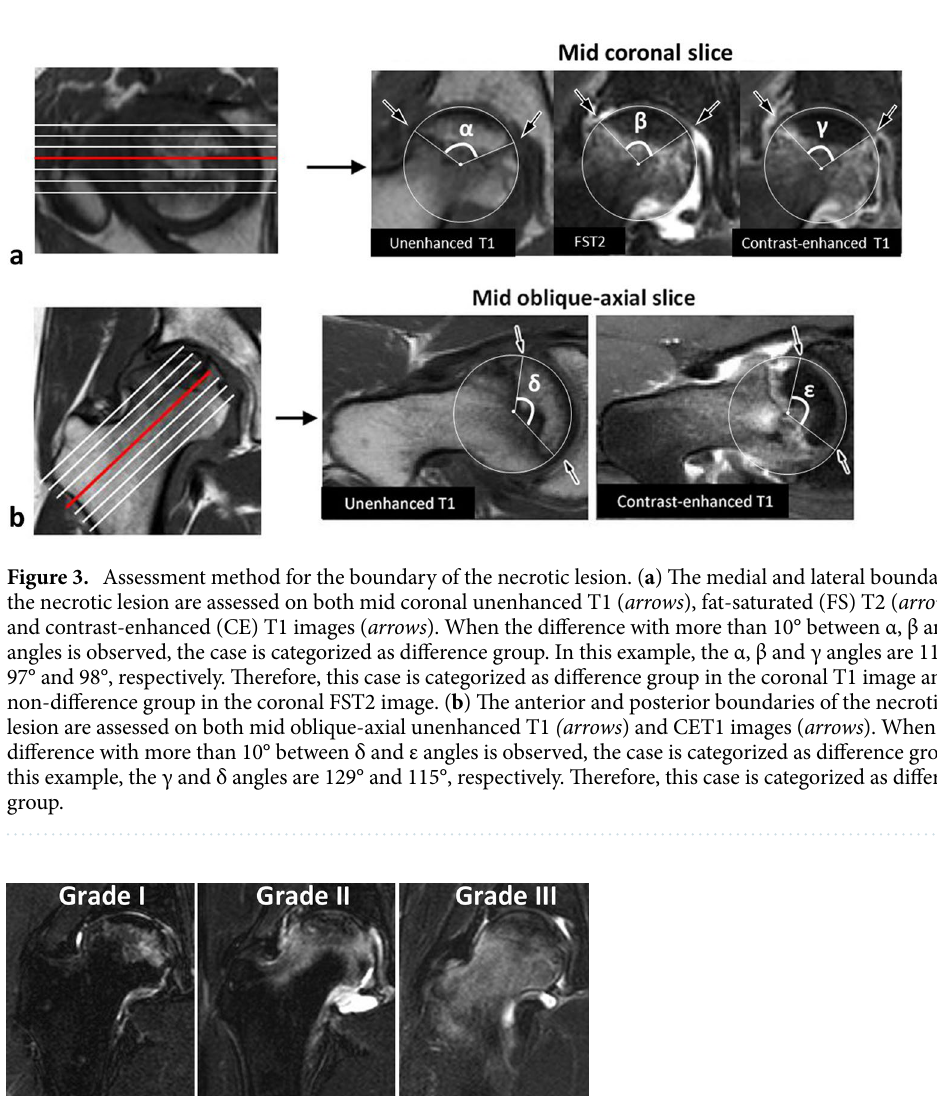
Figure 4. Assessment method for the degree of extension of BME. Grade I; BME is limited within the femoral head. Grade II; BME exceeds the femoral head but remains within the femoral neck. Grade III; BME exceeds the femoral neck reaching the trochanteric